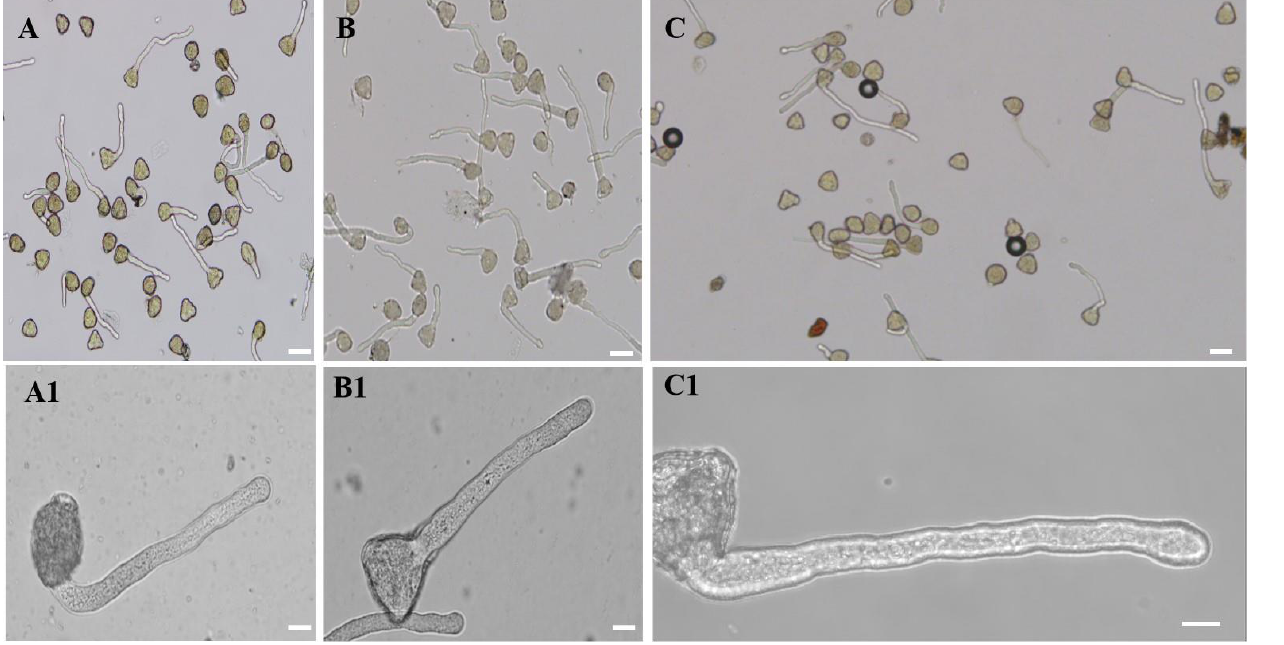
Figure 1. Effect of different concentration of AlCl 3 on pollen tube morphology. Control pollen tubes. ( A ) Control pollen tubes. ( A1 ) One control pollen tube. ( B ) Pollen tubes treated with 20 µM AlCl 3 . ( B1 ) One pollen tube treated with 20 µM AlCl 3 . ( C ) Pollen tubes treated with 50 µM AlCl 3 . ( C1 ) One pollen tube treated with 50 µM AlCl 3 . Bar = 25 µm. Table 1. Germination rate and length of pollen tubes under different concentrations of AlCl 3. Concentration of AlCl 3 /µM Germination Rate/% Pollen Tube Length /μm